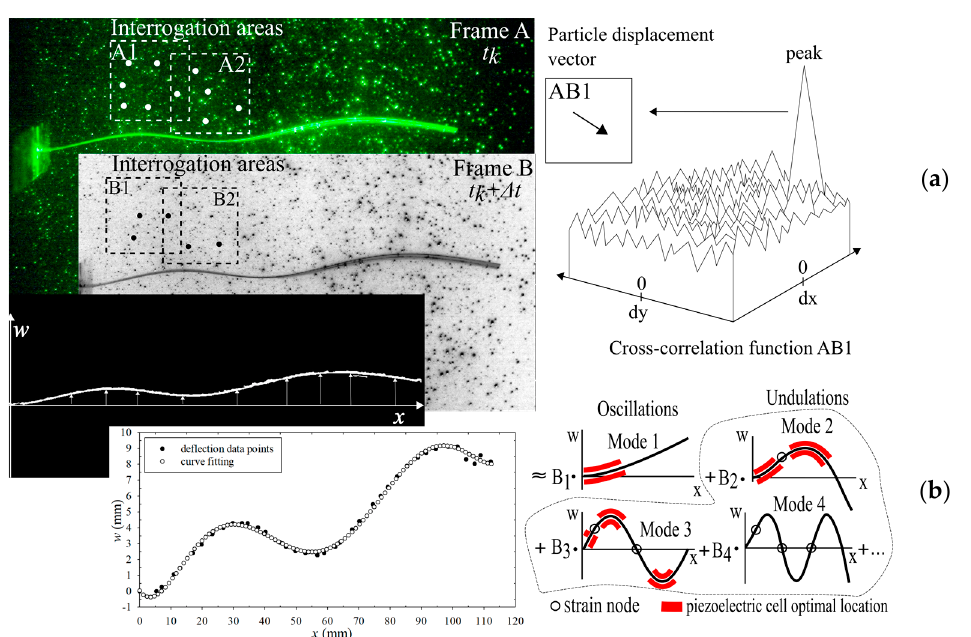
Figure 2. Experimental procedure: ( a ) particle image velocimetry principle; ( b ) shape capture, curve fitting and modal analysis.